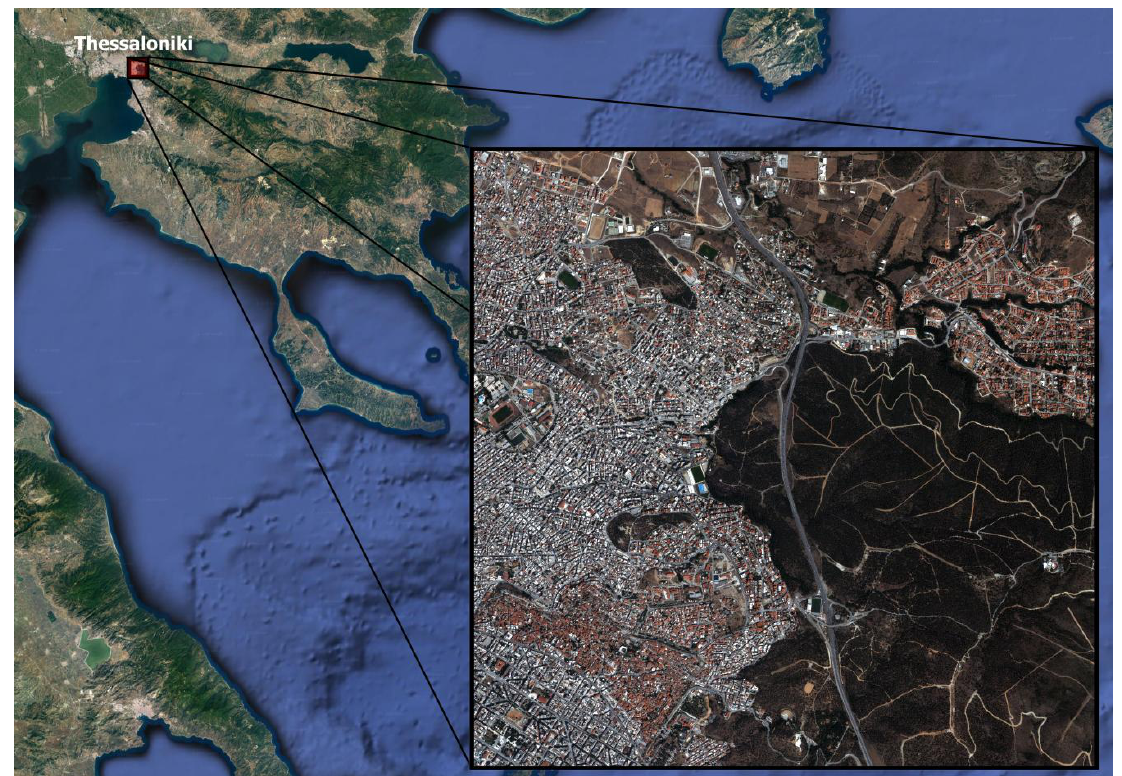
Figure 1. Study area in Google Maps (left) and Quickbird Pansharpened image of the year 2010 (right) (Source: Google Maps, modified by the